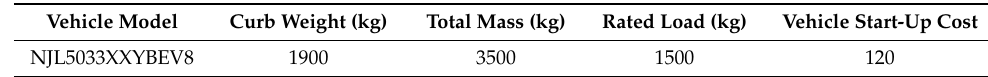
Table 4. The delivery vehicle model parameter table.